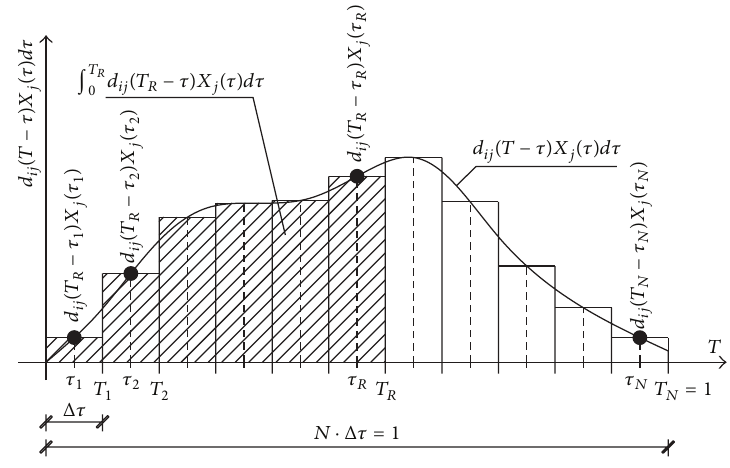
Figure 8: Numerical calculations